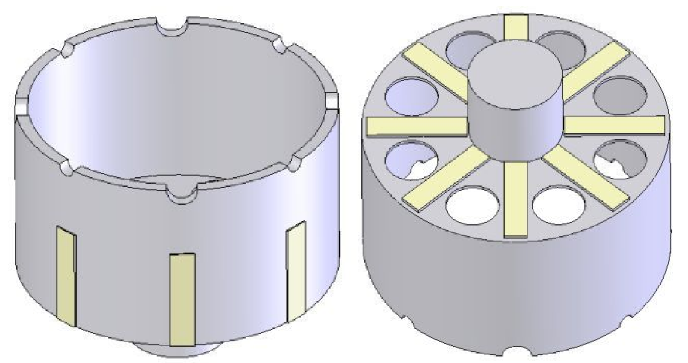
Figure 1. The basic structure of the cylinder